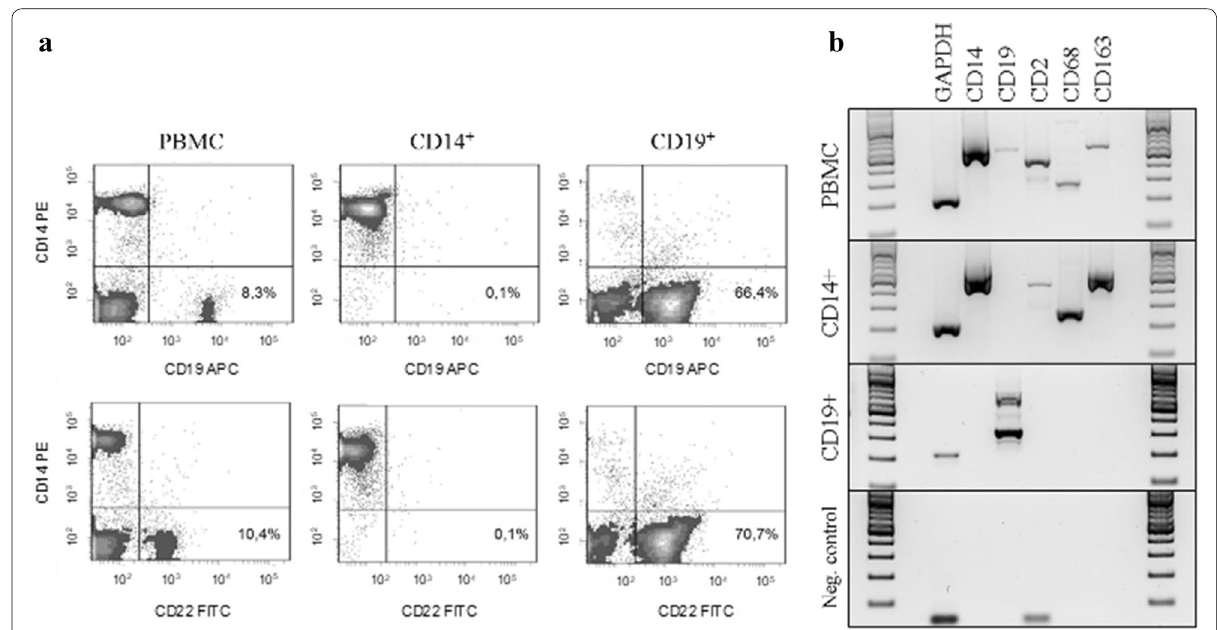
Fig. 1 Purity of the isolated CD14‑positive cells validated by flow cytometry and gene expression profiling. a Flow cytometry of freshly isolated MACS purified CD14 + monocytes of one representatively chosen blood sample demonstrating purity of routinely 99.9% and absence of CD19 + / CD22 + B cells. The analyses of PBMCs and CD19 + B cells are shown as positive controls for the used antibodies. b RT‑PCR profiling is shown for CD14 + monocytes from one representative healthy individual. Expression of GAPDH, B cell (CD19), T cell (CD2) and monocyte/macrophage marker genes (CD14, CD68, CD163) demonstrates the quality of the isolated cell preparations and the absence of detectable quantities of B or T cells. PBMC and CD19 + B cells are demonstrated as reference. GAPDH glycerinaldehyd‑3‑phosphat‑dehydrogenase, PBMC peripheral blood mononuclear